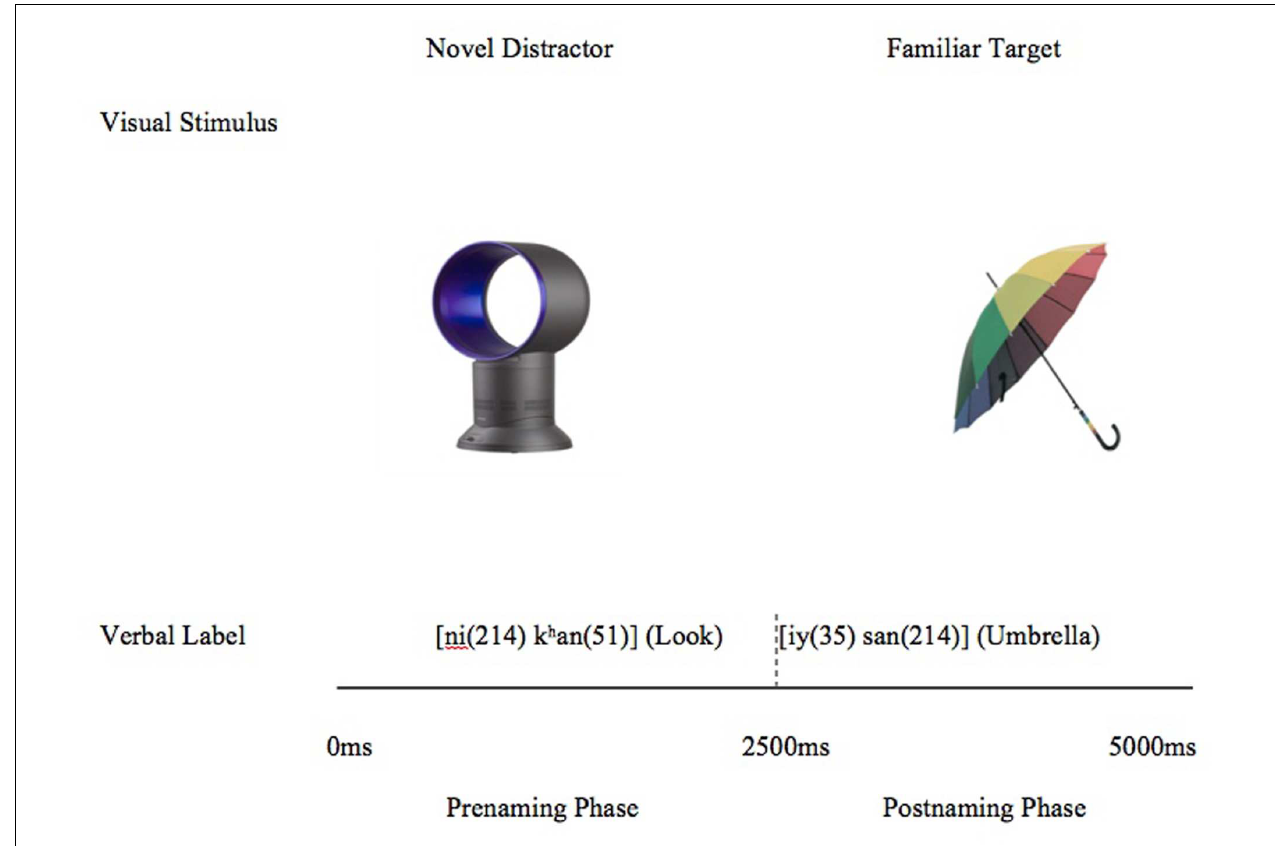
FIGURE 2 | Sequence of events in each experimental